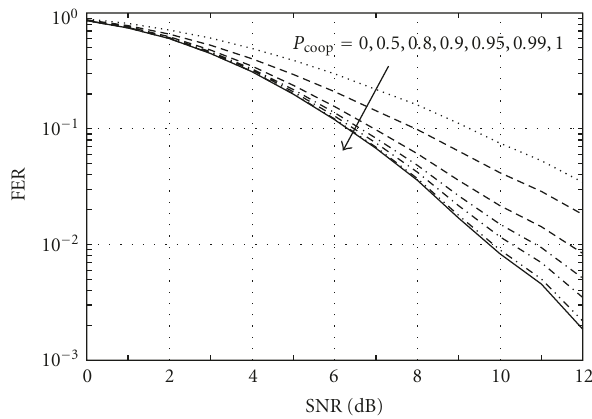
Figure 5: FER versus SNR for BPSK modulation, optimal gen- erators for AWGN, 8 states, 1 relay, 2 transmitting antennas per node, 1 receiving antenna, respectively, in quasistatic fading channel ( L =